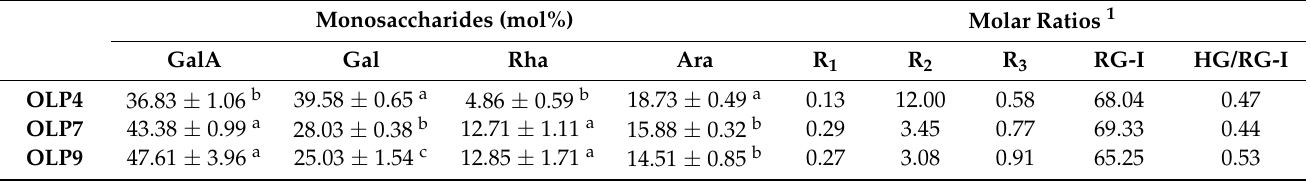
Table 2. Monosaccharide composition and molar ratios of polysaccharides from okra leaves (OLPs). Monosaccharides (mol%) Molar Ratios 1